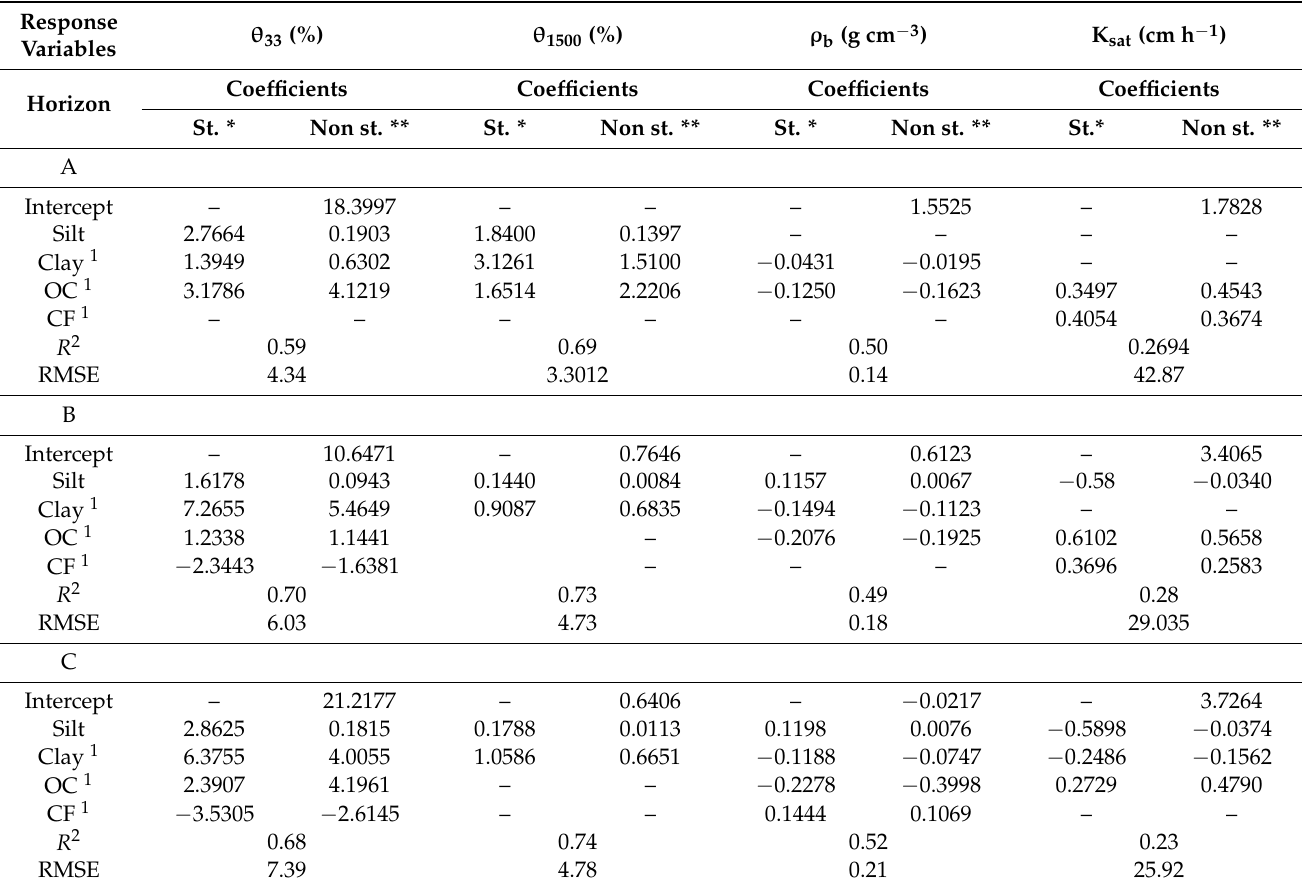
Table 4. Standardized (St. *) and non-standardized (Non st. **) regression coefficients obtained by stepwise forward